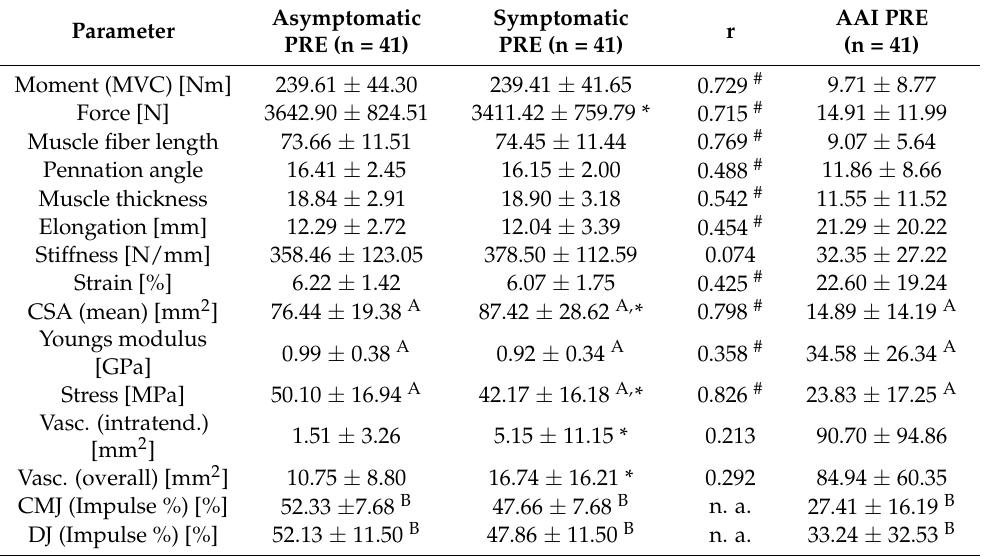
Table 3. Comparison of Achilles tendon mechanical, morphological, material, and functional proper- ties, as well as vascularization of the plantar flexor muscle-tendon unit between asymptomatic and symptomatic leg and corresponding absolute asymmetry indices (AAI) of the overall patient group at baseline (PRE). Data are presented as mean ± standard deviation (SD). The corresponding pearson correlation coefficient (r) between sides is reported.